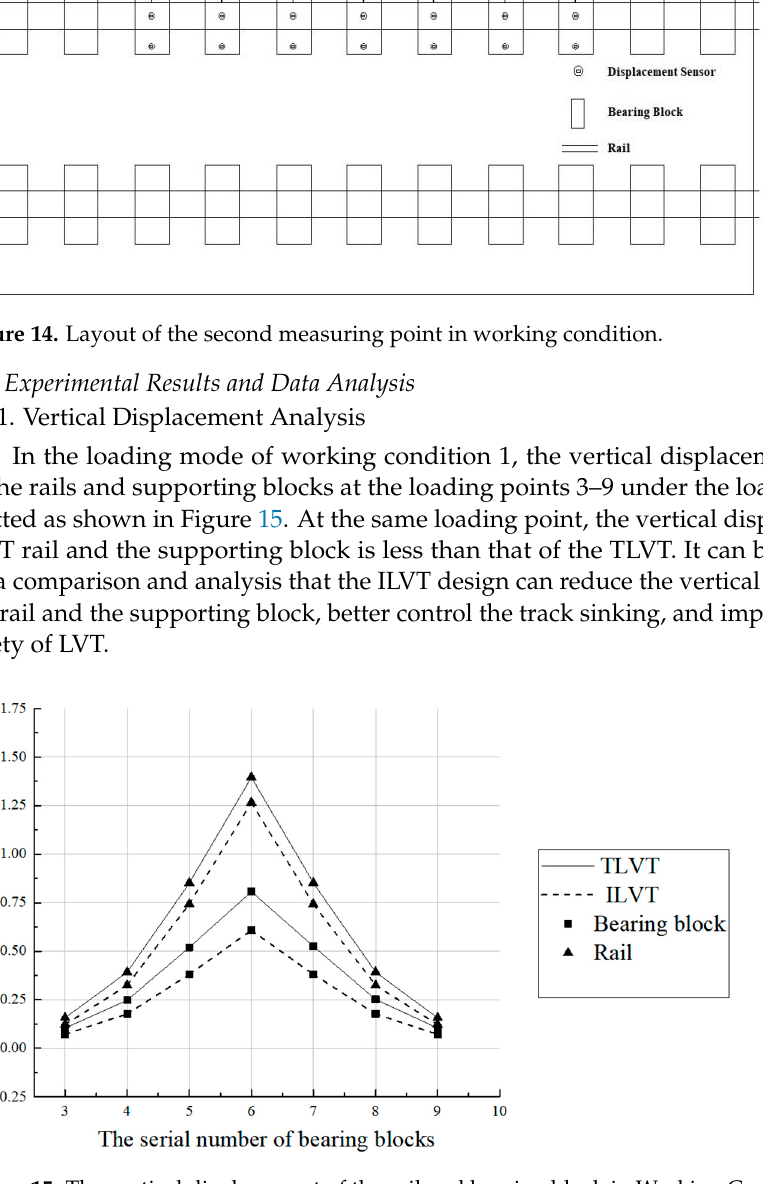
Figure 13. Loading mode of working condition 2.